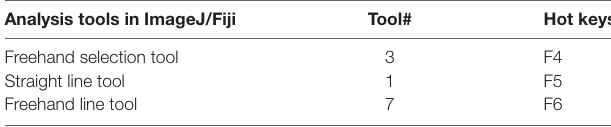
TABLE 1 | A list of hot keys, encoded in macros for ImageJ/Fiji. Analysis tools in ImageJ/Fiji Tool# Hot keys Freehand selection tool